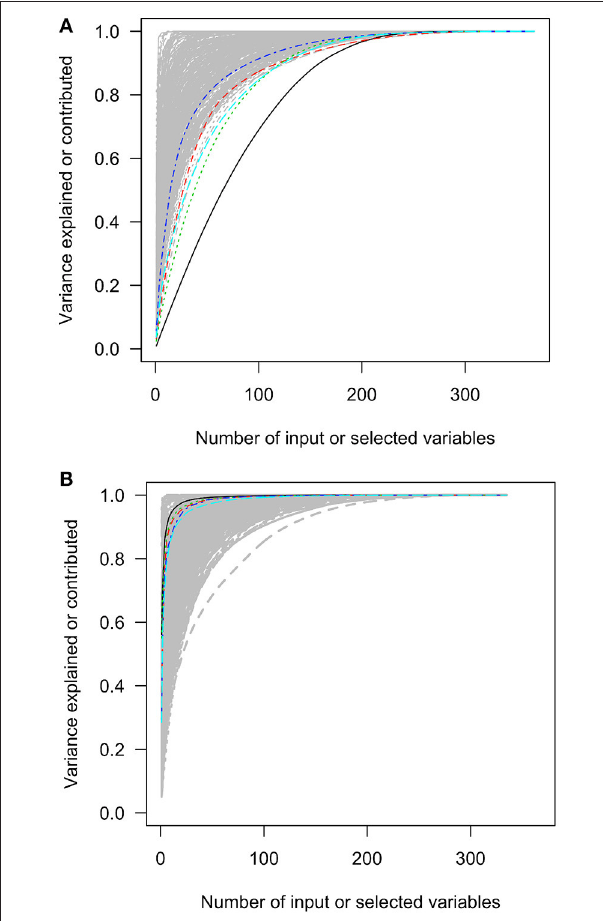
FIGURE 5 | The squared loadings in each PC and the R squared of PC approximation in the Canadian Health Measures Survey cycle 1–3 data. (A) The squared loadings of all variables in PCs. (B) The adjusted R squared of the variables that were used to approximate PCs. PC, principal component. Black, first PC; red, second PC; green, third PC; blue, fourth PC; light blue, fifth PC.